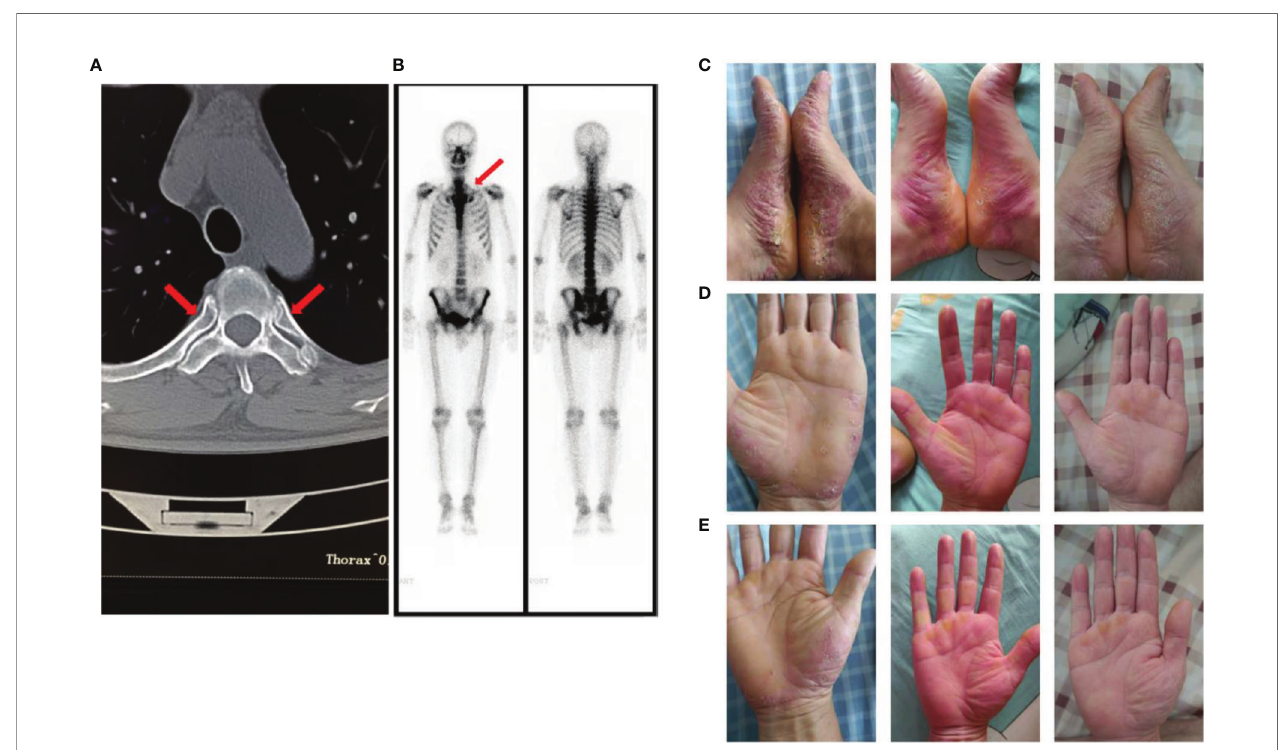
FIGURE 1 | (A) The computed tomography image showed in fl ammatory changes of the breastbone; (B) The “ bull ’ s head sign ” on bony scintigraphy; (C) Palmoplantar pustulosis (PPP) on the patient ’ s palms and feet before using tofacitinib; (D, E) . PPP on the patient ’ s palms and feet after using tofacitinib for one month and two